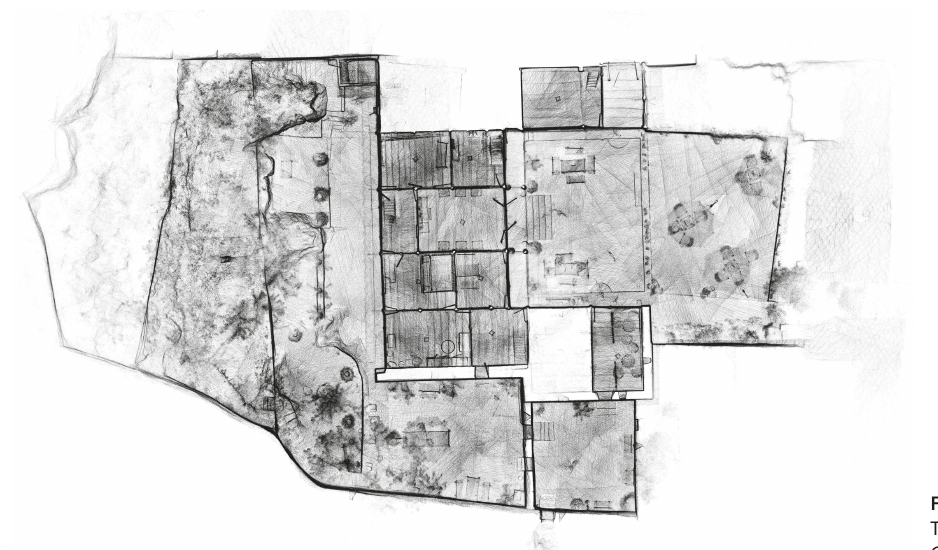
Figure 4 Point cloud map of a Tunpu house in Benzhai Village, Guizhou Province (Source: Leigh Shutter and Chen Yang).